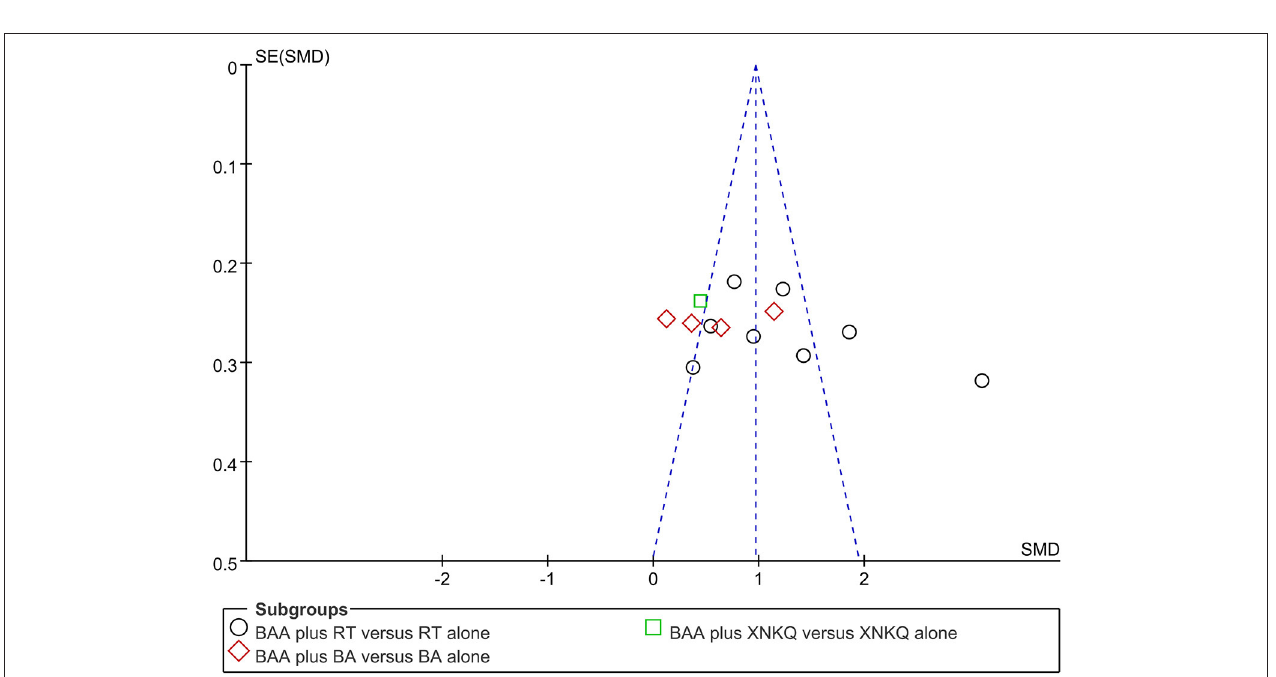
FIGURE 7 | Funnel plots illustrating meta-analysis of FMA. (BA, body acupuncture; BAA, Bo’s abdominal acupuncture; FMA, Fugl-Meyer Assessment Scale; WMD, weight mean difference; RT, rehabilitation training; SE, standard error; XNKQ, Xingnao kaiqiao acupuncture).